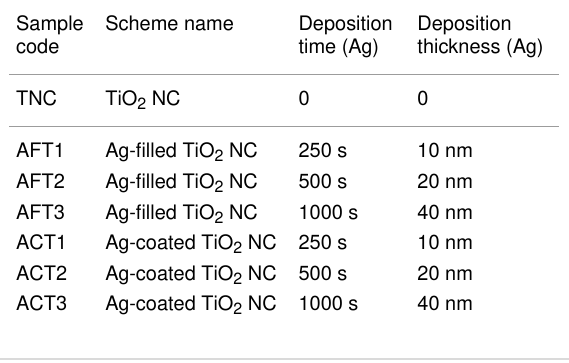
Table 1: Summary of the preparation conditions of Ag-loaded TiO 2 samples. Sample